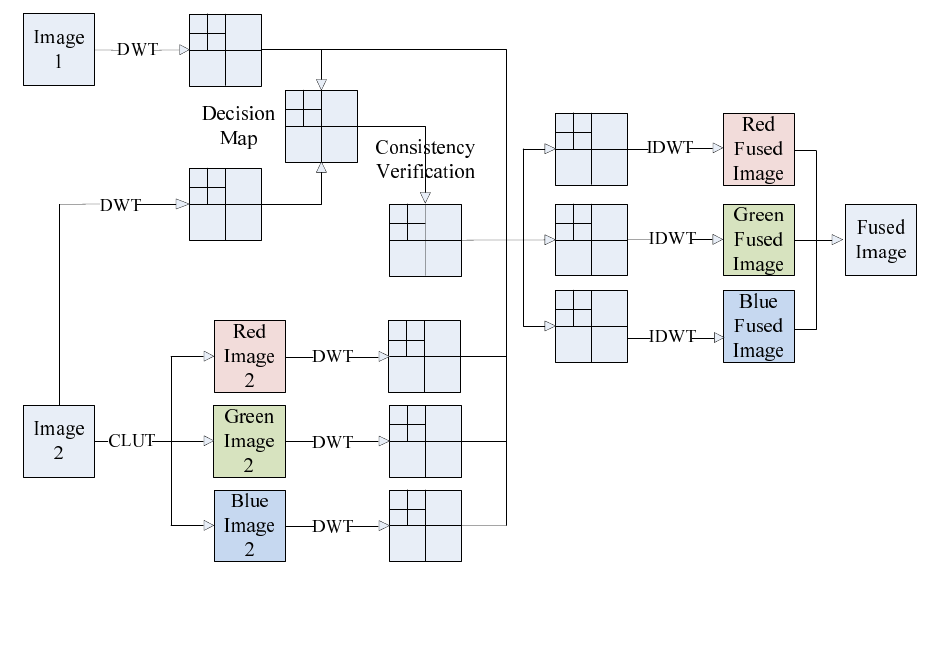
Figure 38. Fusion scheme of the novel Wavelet-based